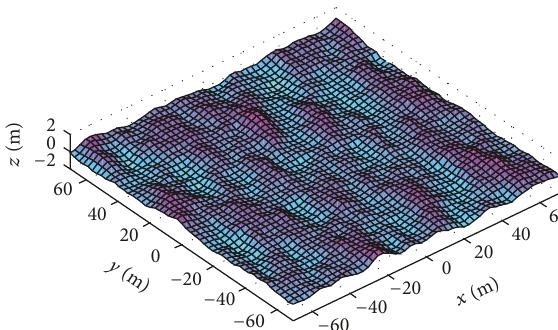
Figure 4: Simulation result with the 30 sampled waves for Sea State 3.